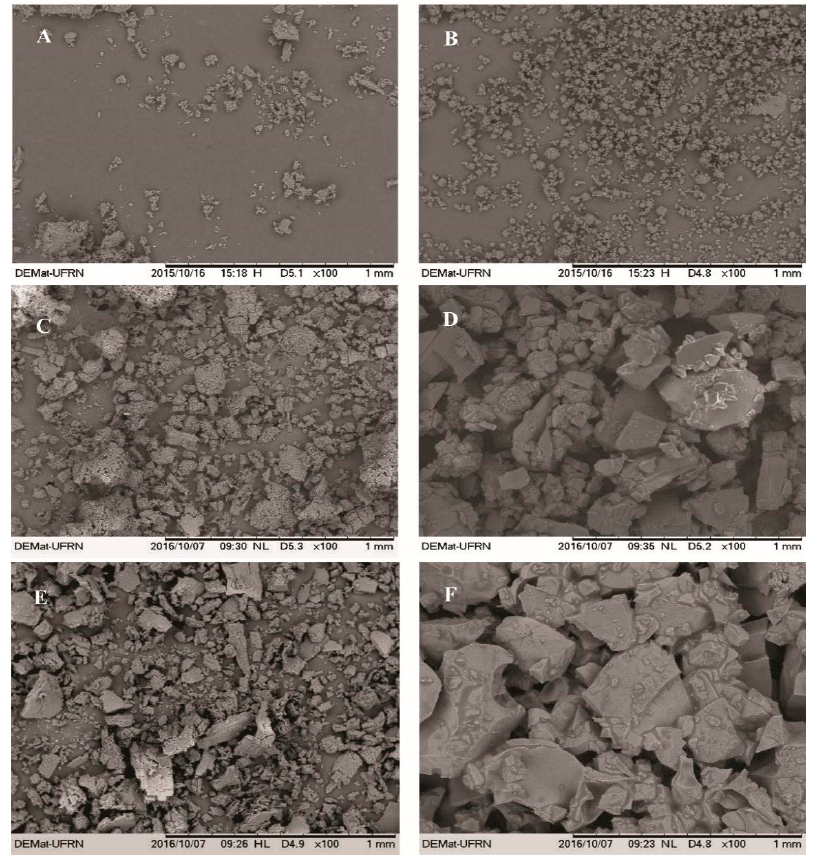
Figure 3. SEM micrographs of β -cyclodextrin ( A ), hydroxy-propyl- β -cyclodextrin ( B ), EOO- β -cyclodextrin inclusion complexes prepared by kneading ( C ) and slurry ( E ), and EOO-hydroxy-propyl- β -cyclodextrin inclusion complexes prepared by kneading ( D ) and slurry ( F ). Images were taken at a magnification of 100×.